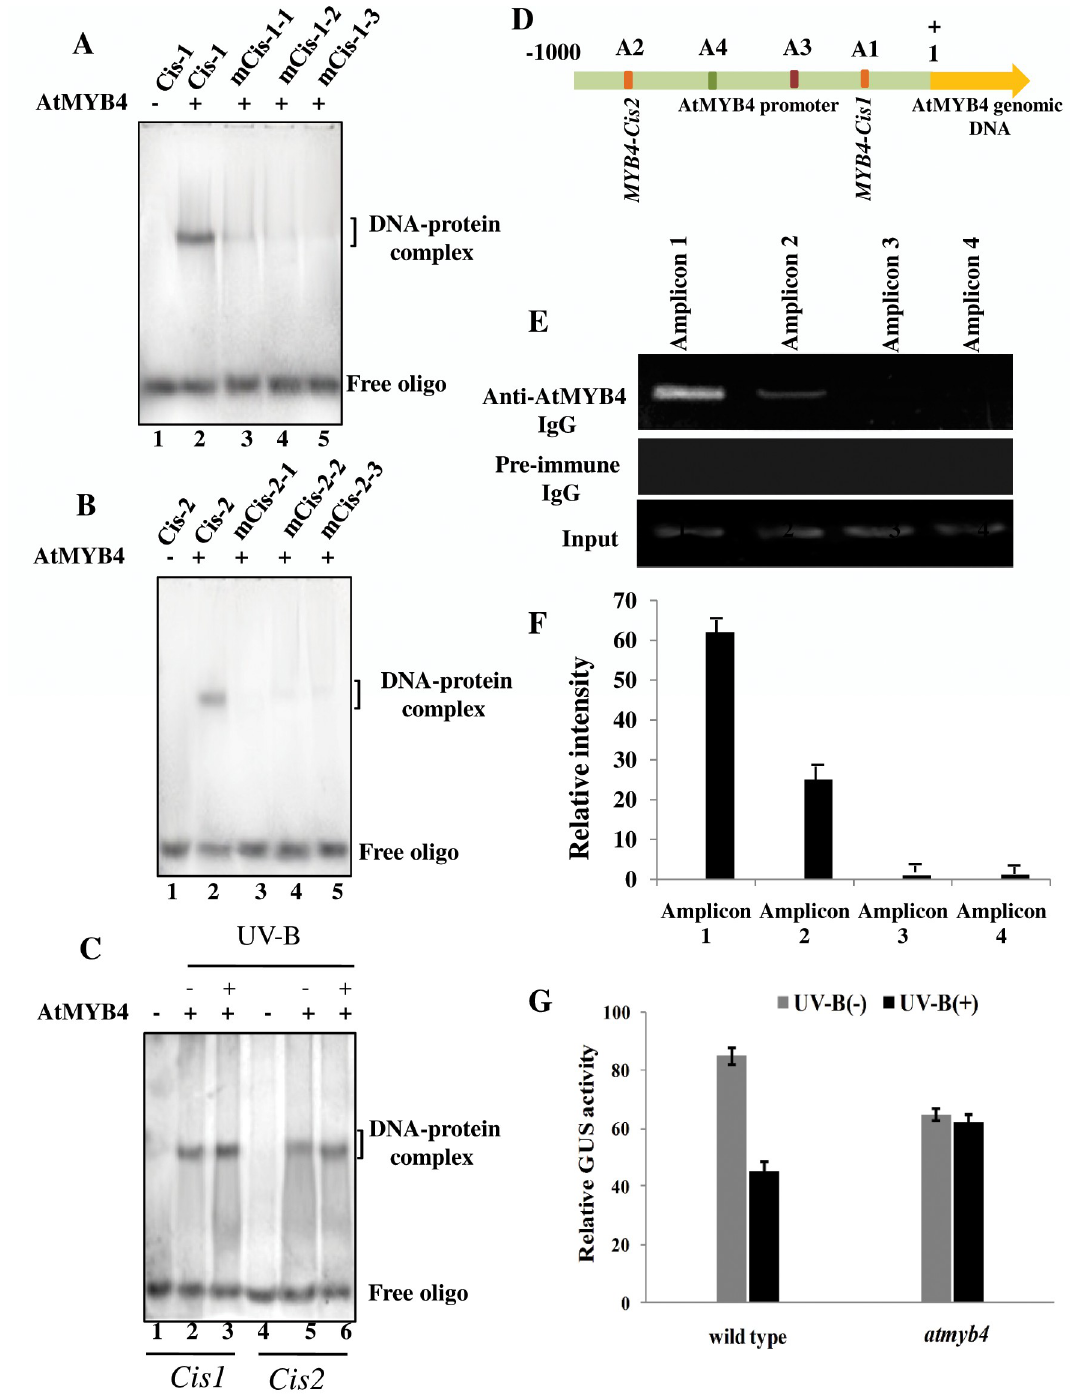
Fig 9. Binding specificity of AtMYB4 to the putative MYB4 motifsA and B. Gel mobility shift assays were carried out using recombinant AtMYB4 with the wild-type and mutant versions of MYB4-Cis1 (A) and MYB4-Cis2 oligos (B). No protein was added in lane 1 while lane 2 contained wild-type MYB4-Cis1 or MYB4-Cis2 . Lanes 3–5 contained mutant versions of MYB4-Cis1 (A) or MYB4-Cis2 (B), respectively. Representative gel images from at least three independent experiments have been shown. C. Gel mobility shift assays using untreated control and UV-B irradiated recombinant AtMYB4 with MYB4-Cis1 (A) and MYB4-Cis2 oligos. No protein was added in lanes 1 and 4, while lanes 2 and 5 contained untreated control recombinant AtMYB4. UV-B irradiated recombinant AtMYB4 protein was used in lanes 3 and 6. 10 μ g of purified recombinant AtMYB4 used in the reaction with 125 ng of